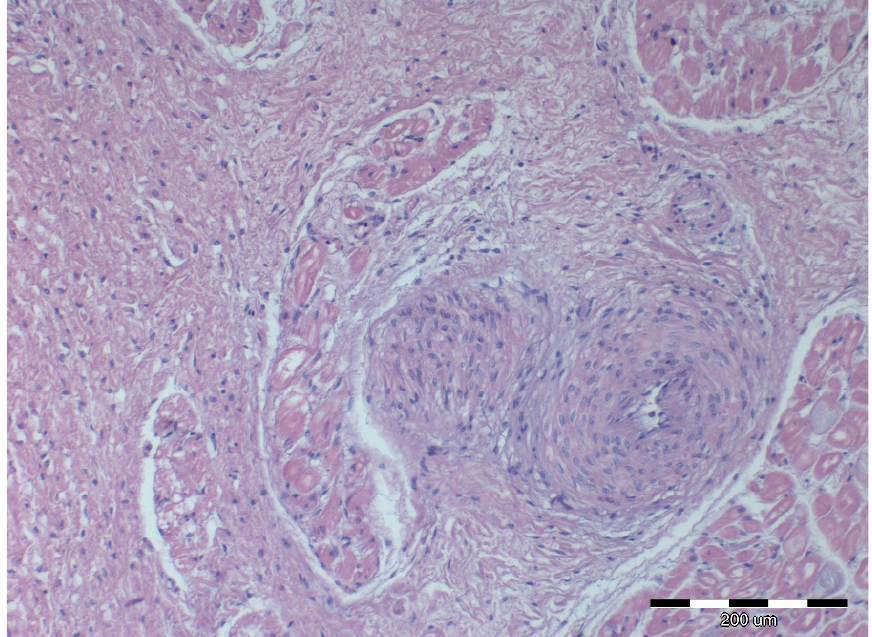
Figure 9. Microscopic image of the heart muscle specimen with coronary artery from an extremely obese horse. The wall of the right atrium: a coronary vessel with a thickened wall and reduced lumen; strong degeneration of the heart muscle cells; very intense perivascular fibrosis extending between the remaining cardiomyocytes; HE staining; 100×.